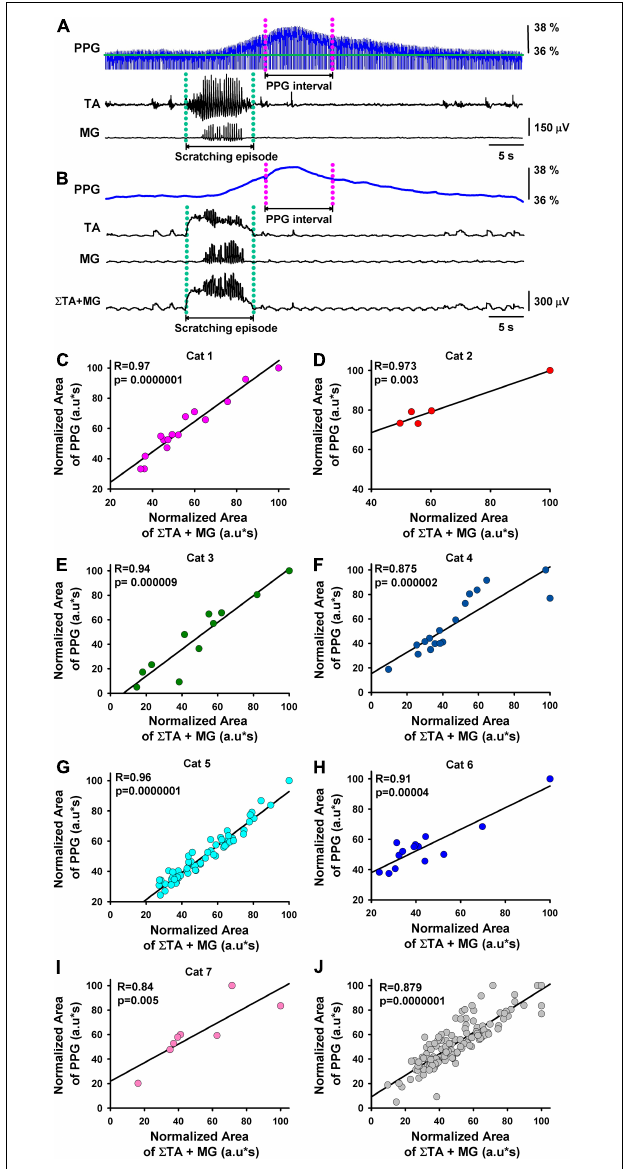
FIGURE 2 | Correlation between the functional DC-PPG in the spinal cord versus the summated motor response during episodes of motor action. (A) The same as Figure 1D , but for another episode of fictive scratching. A functional DC-PPG interval was defined as follows: (1) The magenta lines delimit the duration of the functional DC-PPG interval equal to the duration of the scratching episode, indicated with green lines. (2) We positioned the functional DC-PPG interval around its maximal peak amplitude. (B) The same as in panel (A) , but after the functional DC-PPG signal was lowpass filtered, and the TA and MG electroneurograms were integrated and rectified. The lower panel in panel (B) shows a sum of the integrated and rectified TA and MG signals. (C–I) Results obtained from normalized data of seven cats. The graph shows the “normalized area below the summated TA and MG motor responses” versus the “normalized area below the functional DC-PPG signal” in the spinal cord during the fictive scratching episodes. (J) Superimposed graphs illustrated in Panels (C–I) , Pearson’s correlation with 140 degrees of freedom (df). The coefficient ( R ) and p -value are indicated. Note that all correlations are statistically significant p = 0.005 in one case and p < 0.0001 for all the other